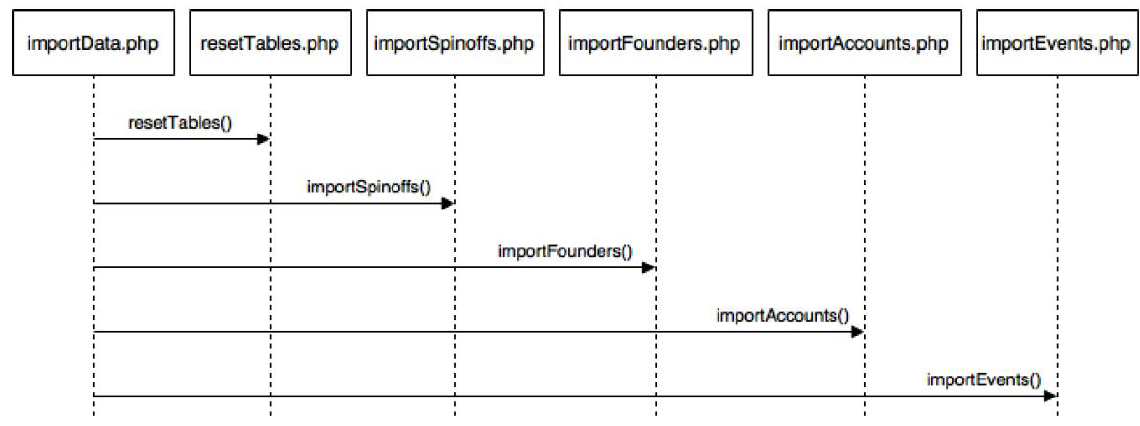
Fig. 2 Sequence diagram of the data import